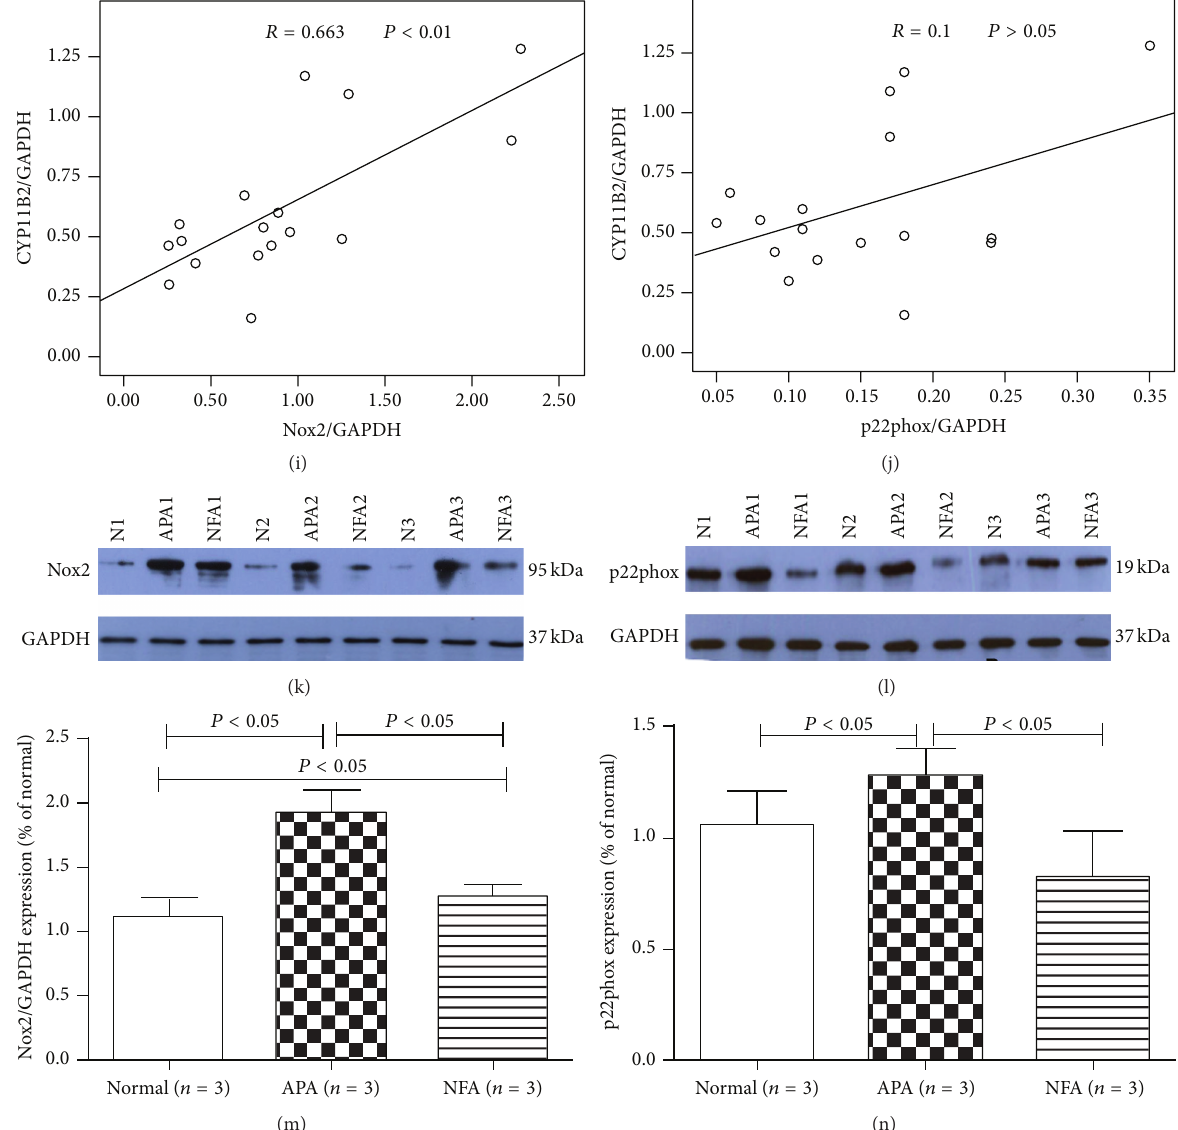
Figure 1: Activity and expression of Nox in different adrenal tissues. (a) Nox activity was detected in normal adrenocortical tissue, APA, and NFA by lucigenin chemiluminescence. (b) Expression of Nox1 – Nox5 , Duox1 , Duox2 , and p22phox mRNA in normal adrenocortical tissue and APA by RT-PCR. Signals for Nox1 , Nox2 , Nox4 , Duox1 , and p22phox were detected in normal adrenal tissue and APA. (c–h) Relative expression of Nox1 , Nox2 , Nox4 , Duox1 , p22phox , and CYP11B2 in normal adrenocortical tissue, APA, and NFA measured by Q-PCR. Nox2 , p22phox , and CYP11B2 were primarily expressed in APA. (i-j) Correlation between CYP11B2 mRNA with Nox2 , CYP11B2 , and p22phox mRNA in APA. A positive correlation between Nox2 and CYP11B2 mRNA was found. (k–n) Western blot analysis of Nox2 and p22phox in normal adrenocortical tissue, APA, and NFA. Nox2 and p22phox were enhanced in APA compared with normal adrenocortical tissue and NFA. Results of densitometric analysis of Nox2 and p22phox proteins normalized to GAPDH were shown.